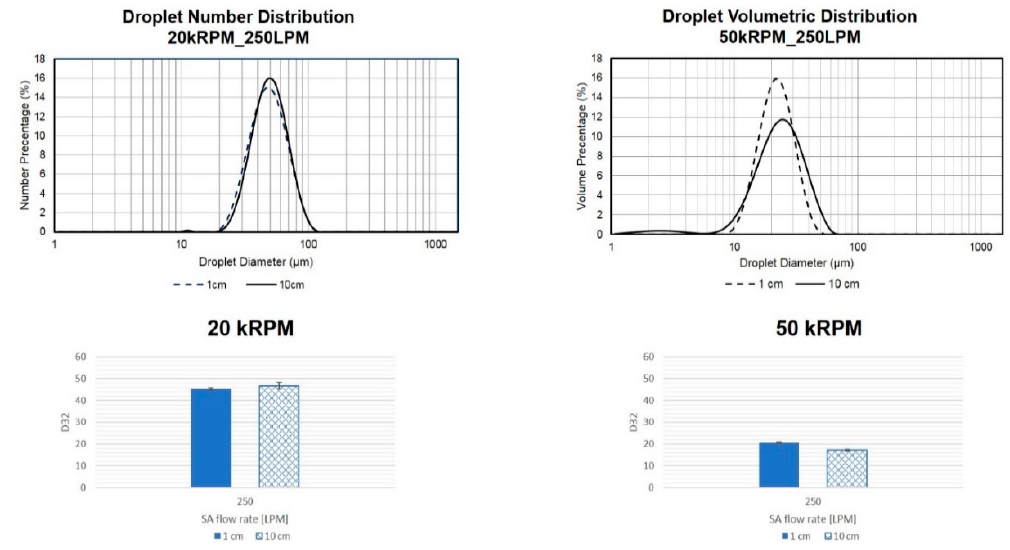
Figure 11. Droplet volumetric distribution versus droplet diameter and Sauter mean diameter for changing cup rotational speeds, at two locations downstream of the cup for a liquid flow rate of 0.1 LPM, and a 250 LPM SA flow rate.